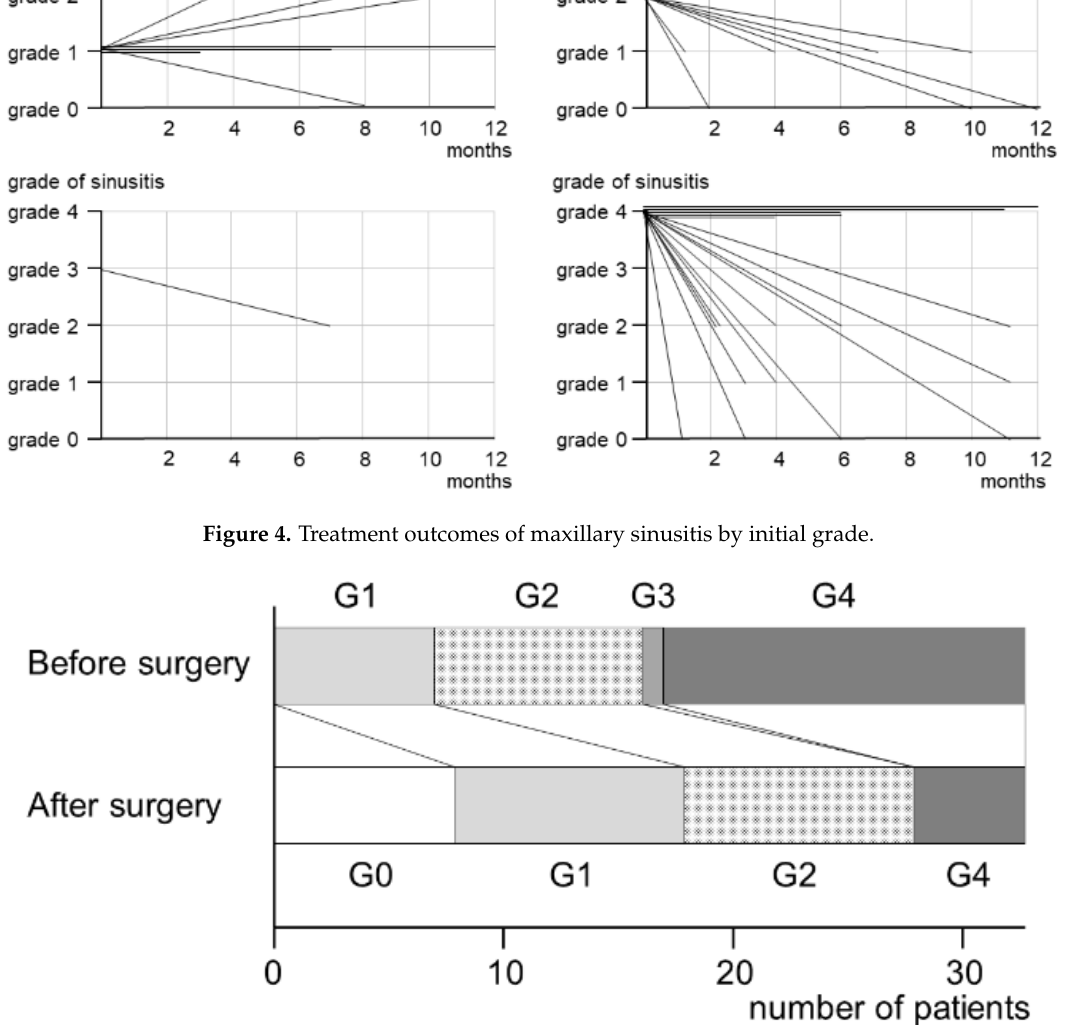
Figure 5. Grade changes of maxillary sinusitis before and after surgery.